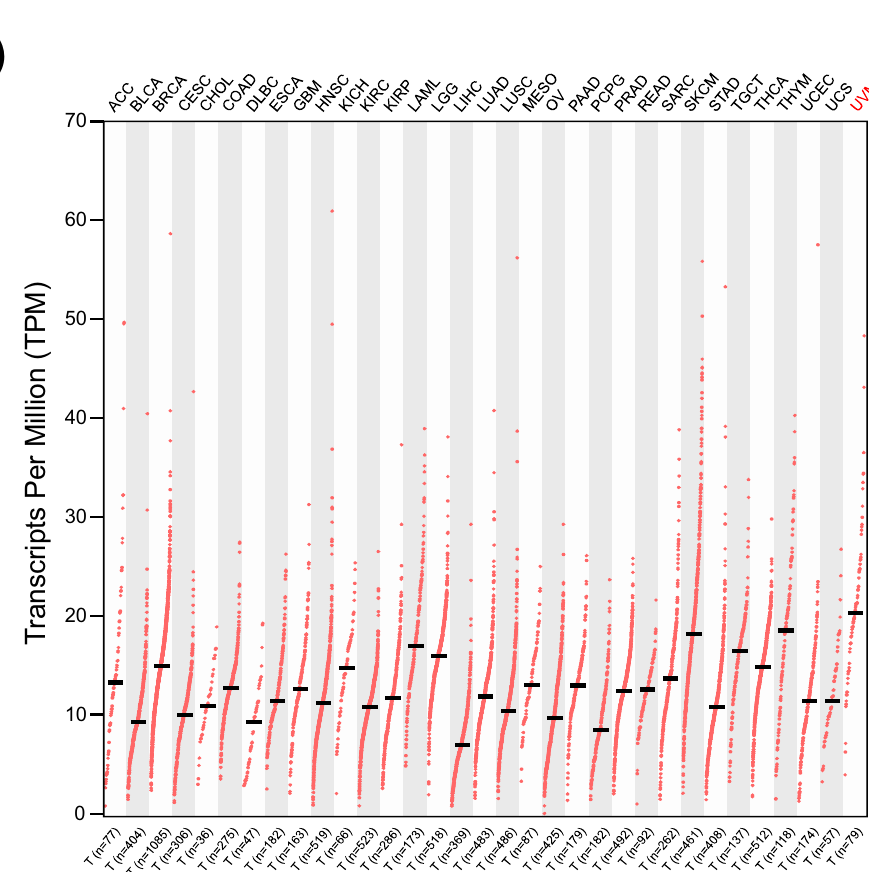
Figure A1: Expression of AMBRA1 across TCGA tumors, TCGA data was mined using the GEPIA2 ( http://gepia.cancer - pku.cn/ ) . UVM, Uveal Melanoma; T, Tumor